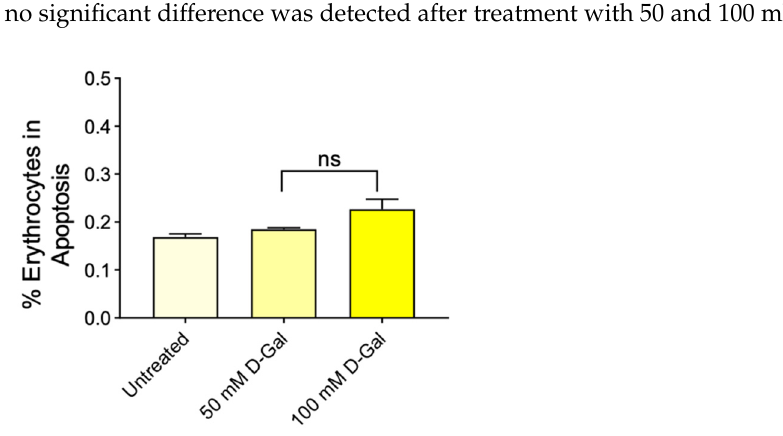
Figure 7. Detection of apoptosis by flow cytometry. Percentage of apoptotic erythrocytes positive to Annexin 5 and Trypan blue detected in samples treated with 50 and 100 mM D -Gal. ns, not statistically significant versus control, ANOVA with Dunnet’s post-test ( n = 8).